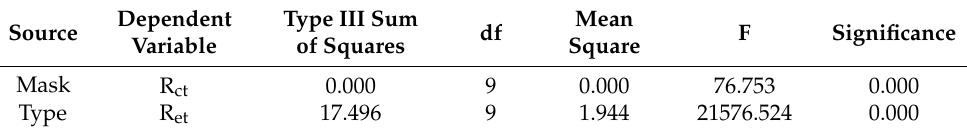
Table 3. The results of variance analysis for masks tested on thermal head